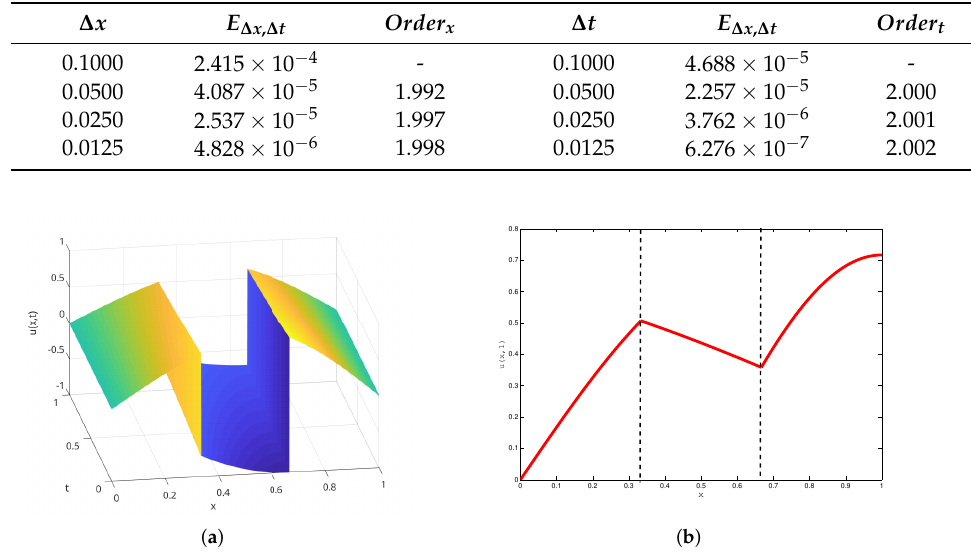
Figure 2. Numerical solution of the mathematical model (6)–(11) with the data of Section 7. ( a ) Full solution for for ( x , t ) ∈ [ 0,1 ] × [ 0,2 ] and ( b ) profile at T =